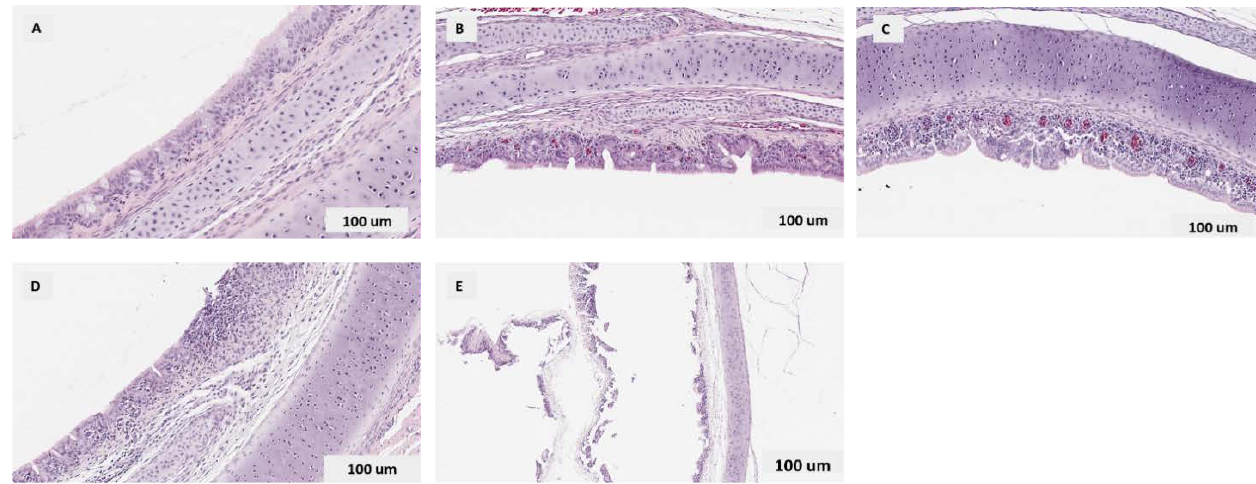
Figure 6. The representative images of the histology of the trachea from ILTV-infected chicken and controls. ( A ) A normal trachea with pseudostratified ciliated columnar epithelium and normal distribution of mucous glands, score 0; ( B ) minimal changes with normal epithelium plus mild to moderate infiltration of lymphocytes, rare heterophils, normal mucous glands, without syncytia or in- tranuclear inclusions, score 1; ( C ) mild changes with thickened mucosa with mild to moderate cell infiltration and/or normal epithelium, except for foci of syncytia, intranuclear inclusions, and hy- peremia, occasionally with cell cuffs, score 2; ( D ) moderate changes with thickened mucosa with moderate to marked cell infiltration, numerous syncytia, intranuclear inclusions, patches of sepa- rating or sloughing epithelium from the lamina propria, the mucosal surface well covered by normal or affected epithelium, mucous glands reduced, marked hyperemia, and mononuclear cell infiltra- tion around blood vessels, score 3; ( E ) severe changes with thickened mucosa, edema, proteinaceous fluid, cellular exudate, or adherent fibrinohemorrhagic to cellular pseudomembrane on the surface, normal epithelium absent, the mucosal surface covered by a thin layer of basal cells, and syncytia with intranuclear inclusions sometimes present, score 4. Quantitative Histopathological Scoring of Tracheal Lesions The histopathological lesion score of the trachea tissues between groups at each time point were compared using the Kruskal–Wallis test with Dunn’s Multiple Comparison Test, to identify groups (Table 1). Two-way ANOVA with Tukey’s multiple comparison were employed for the tracheal mucosal thickness analysis (Table 2). No significant dif- ference in the histological lesion scores of the tracheal mucosal thickness between groups or time points was noted. Table 1. The lesion scoring of histopathological lesions in the tracheas of chickens at 3 and 7 days after exposure to wildtype (AB-S63) and CEO vaccine revertant (AB-S45) ILTV isolates. Bird #